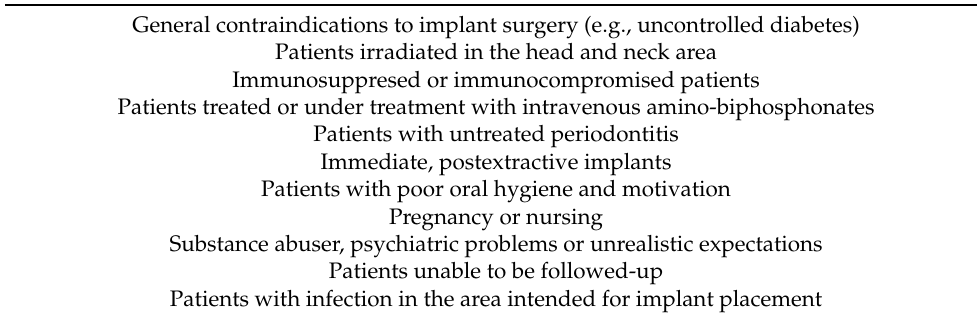
Table 1. Exclusion criteria.